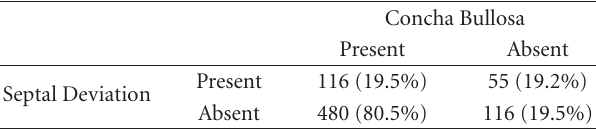
Table 5: Relationship of concha bullosa and nasal septal deviation.